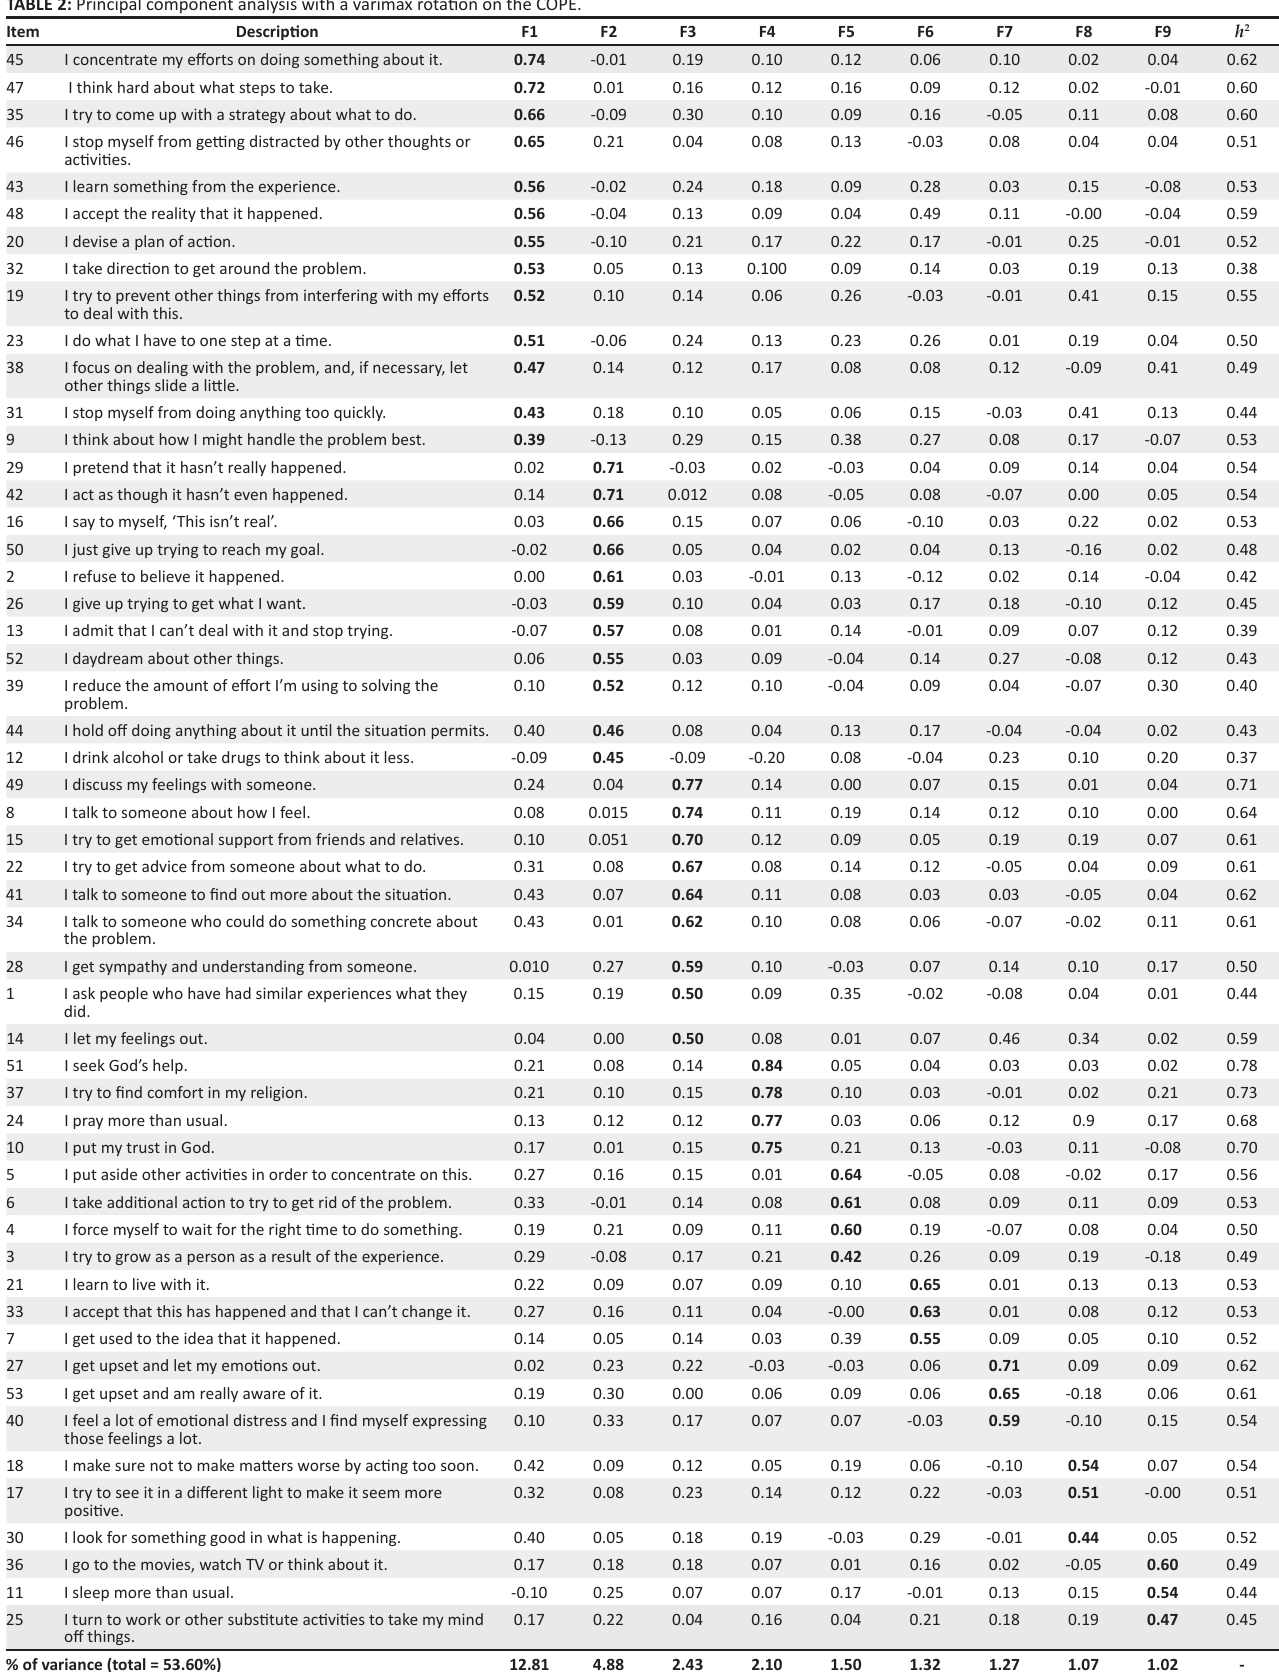
TABLE 2: Principal component analysis with a varimax rotation on the